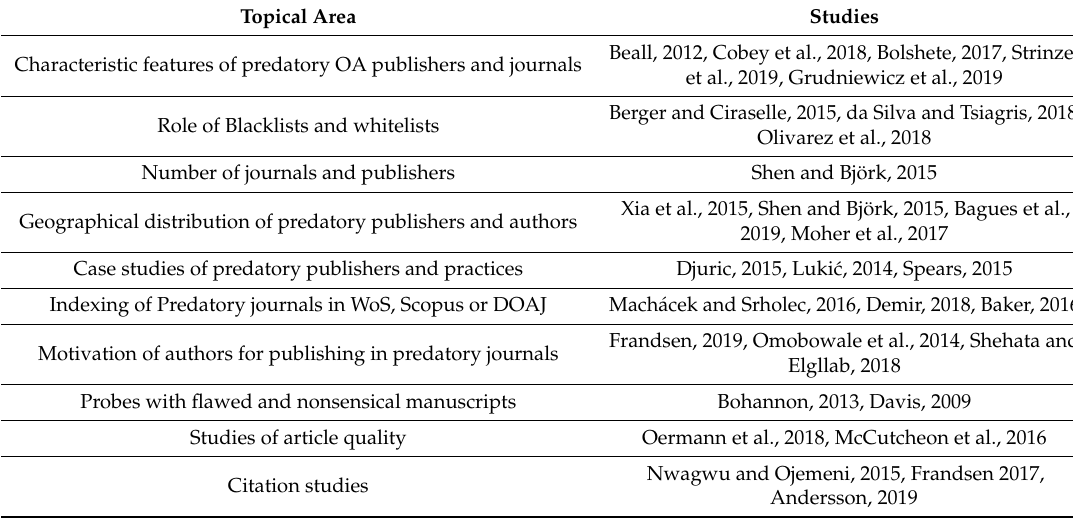
Table 1. Topical areas for studies of predatory Open Access (OA)